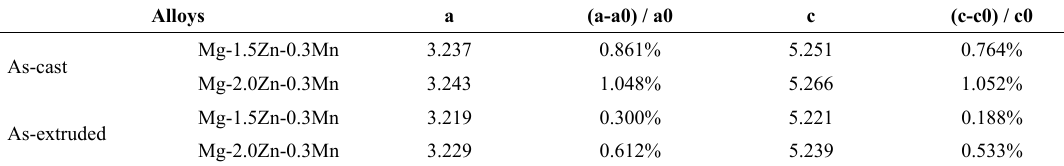
Table 3. The lattice constants of the Mg-xZn-0.3Mn alloysa Alloys a (a-a0) / a0 (c-c0) / c0 As-cast